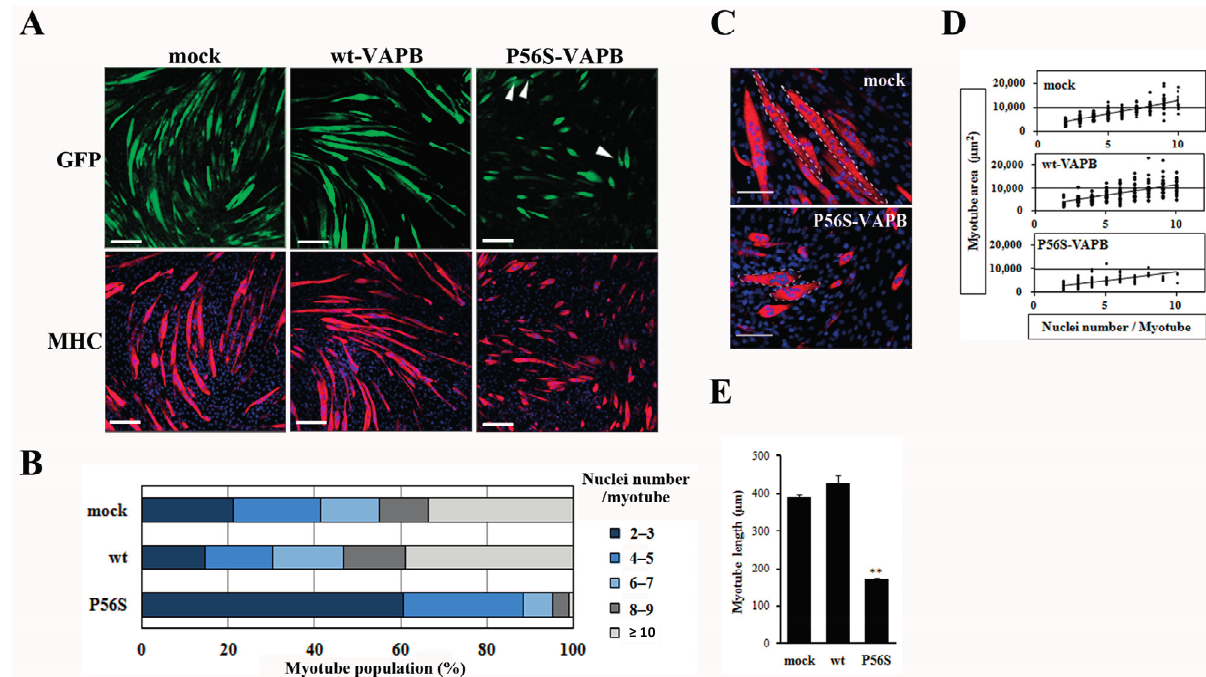
Figure 2. P56S mutation reduces myotube elongation and leads to an aberrant localization pattern of myonuclei. ( A ) C2C12 cells were transfected with the vectors encoding GFP (mock), GFP-fused wt-VAPB, or GFP-fused P56S-VAPB. Then, stable cell lines were generated by G418 selection. Stable cell lines were induced to differentiate until day five. Cells were immunostained using an anti-muscle heavy chain (MHC) antibody and secondary antibody conjugated to Alexa Fluor 568 (red). Nuclei were stained with DAPI (blue). Examples of P56S-VAPB aggregates are indicated with arrowheads. Scale bars = 200 µm; ( B ) The myotube population was segmented according to the number of nuclei per myotube. Each stable cell line was induced to differentiate until day five, and the number of nuclei contained in each myotube was counted. One hundred myotubes were included in each group; ( C ) Image comparison of the mock and P56S-VAPB expressing myotubes at 5 days after differentiation. The white dotted lines outline single myotubes. Mock myotubes contain six ( left ) and eight nuclei ( right ) each. P56S myotubes contain eight ( top ) and seven nuclei ( bottom ) each. Scale bars = 100 µm; ( D ) The myotube area was plotted according to the number of nuclei per myotube. Each stable cell line was induced to differentiate until day five, and the single myotube areas were measured using ImageJ software (National Institutes of Health, Bethesda, MD, USA). n = 214 (mock myotubes), 211 (wt-VAPB myotubes), and 300 (P56S-VAPB myotubes); ( E ) Average myotube length. Each stable line was induced to differentiate until day five, and the single myotube length was measured using ImageJ software (National Institutes of Health, Bethesda, MD, USA). The values are the means ± standard deviation for 300 myotubes in each group. ** p < 0.01 compared with